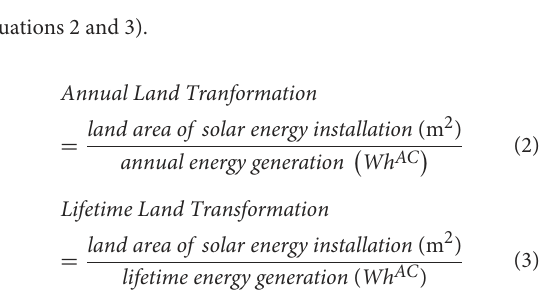
(Equations 2 and